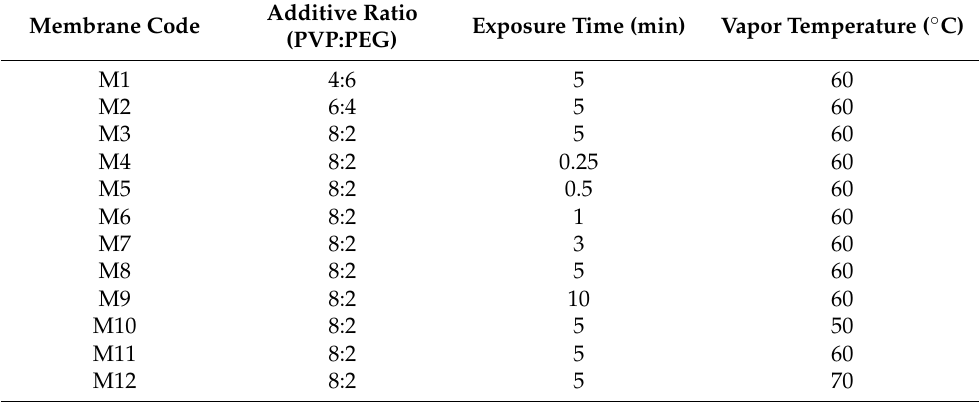
Table 1. Membrane codes for different additive ratios, exposure times and vapor